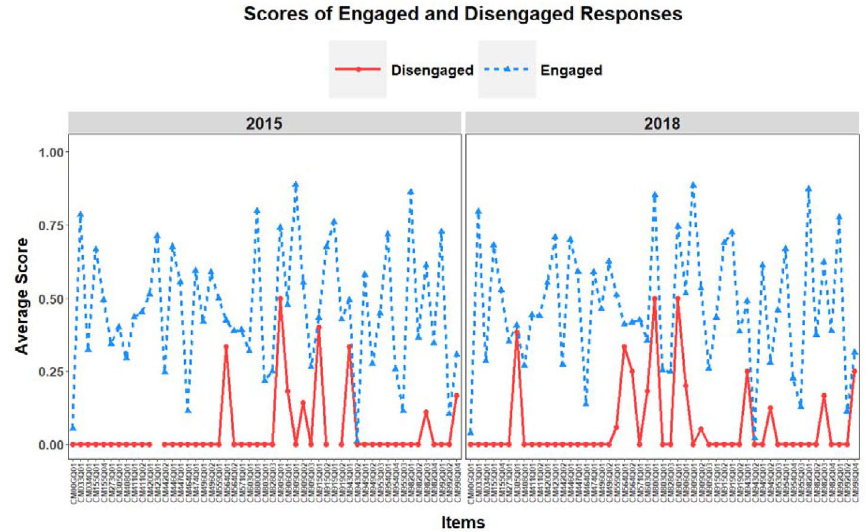
Fig. 3 Scores of engaged and disengaged responses in 2015 and 2018. SOURCE: Organisation for Economic Co-operation and Development (OECD), Programme for International Student Assessment (PISA), 2015 and 2018 Mathematics